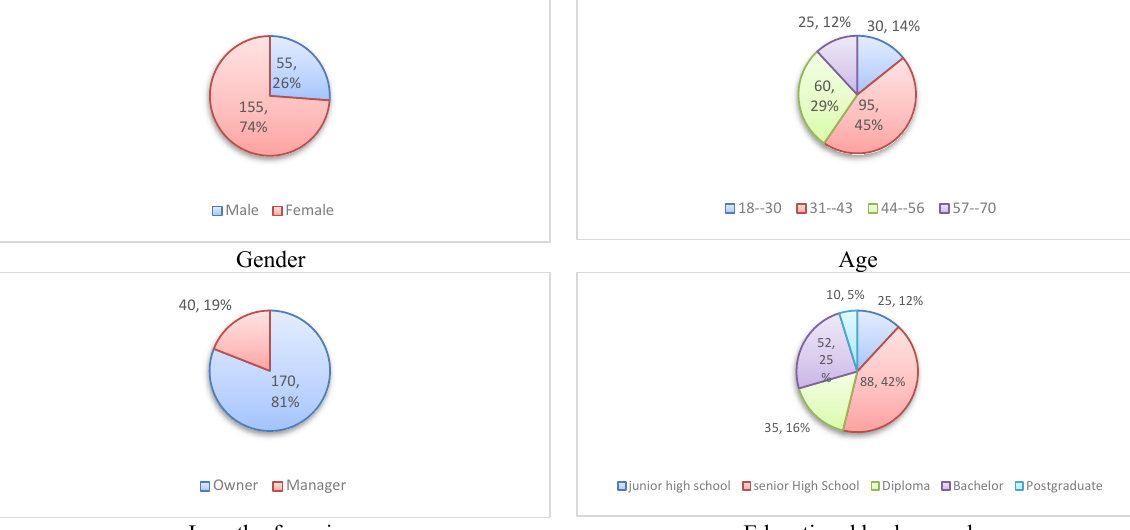
Fig. 2. Personal characteristics of the